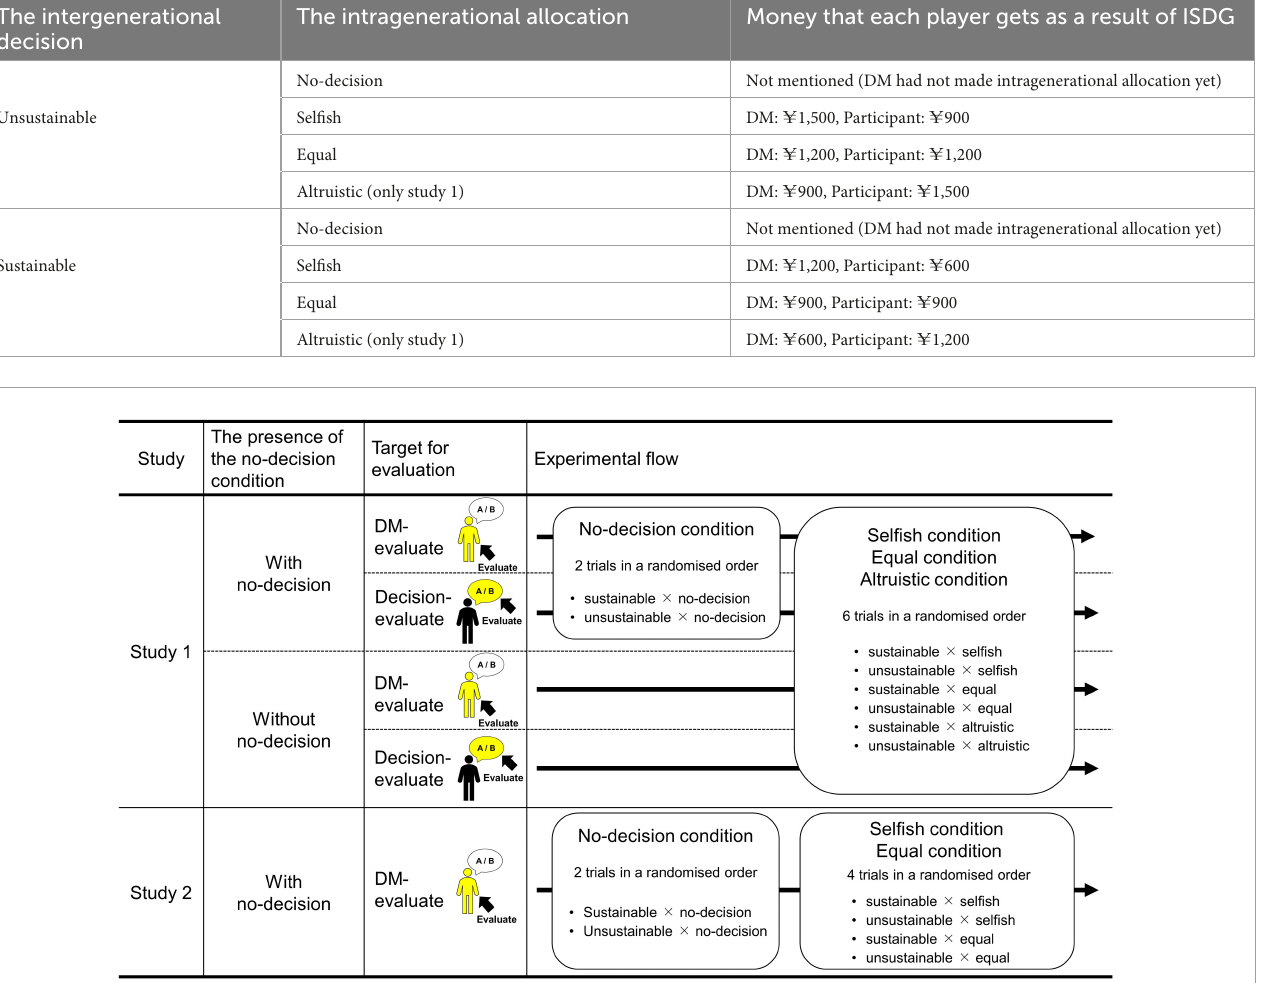
TABLE 2 The list of the evaluator’s gain in each DM with the intergenerational decision and the intragenerational allocation. The intergenerational The intragenerational allocation decision